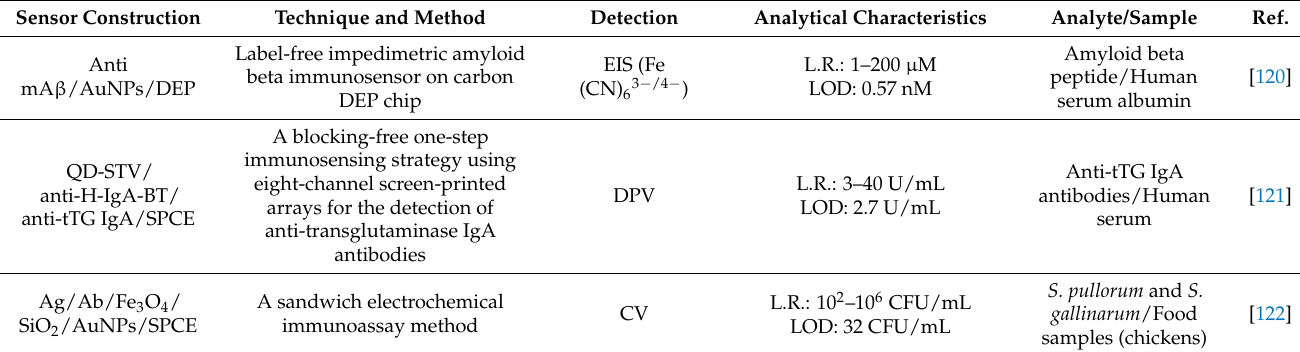
Table 3. Immunosensors for (bio) compound detection in some